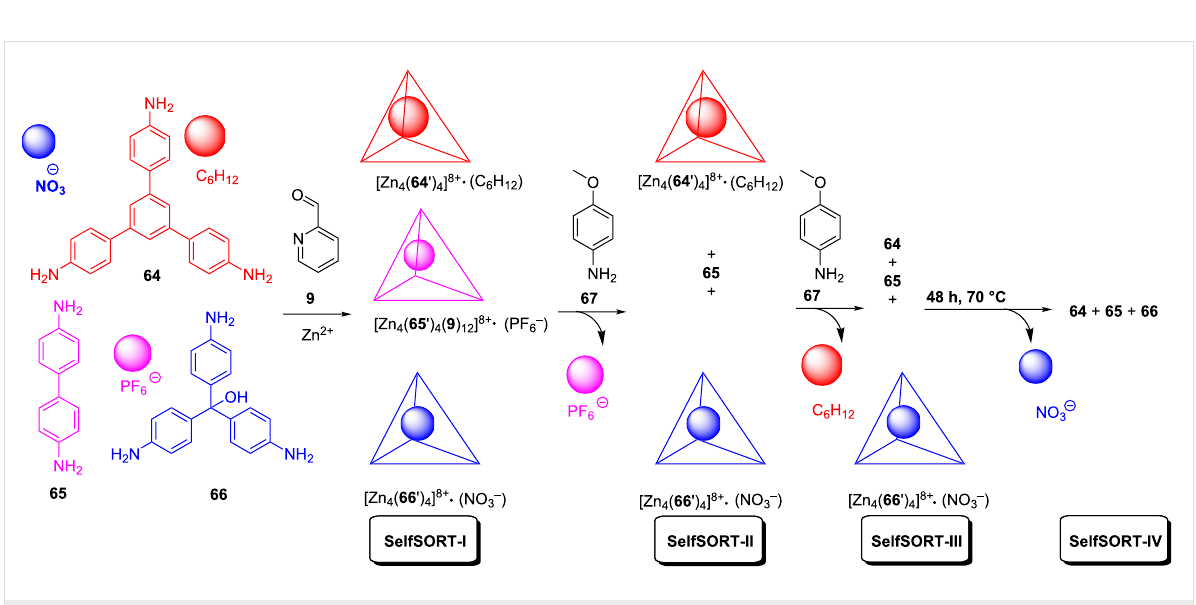
Figure 18: The selective encapsulation and sequential release of guests in a self-sorted mixture of three tetrahedral cages.